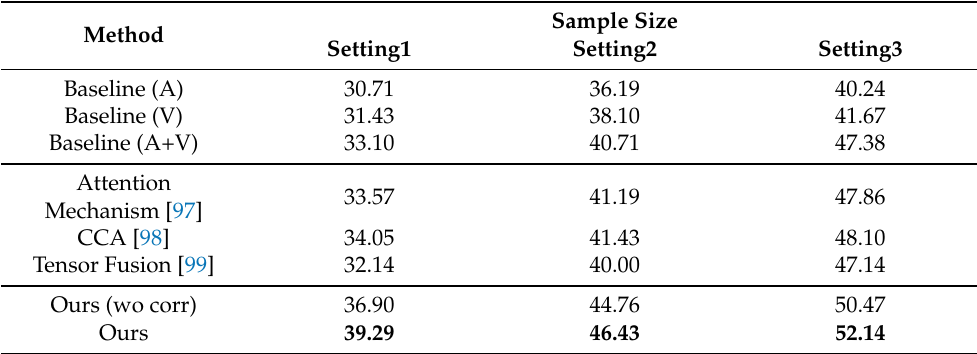
Table 3. Classification accuracy (%) of different methods on the CMEW dataset. Best results are shown in